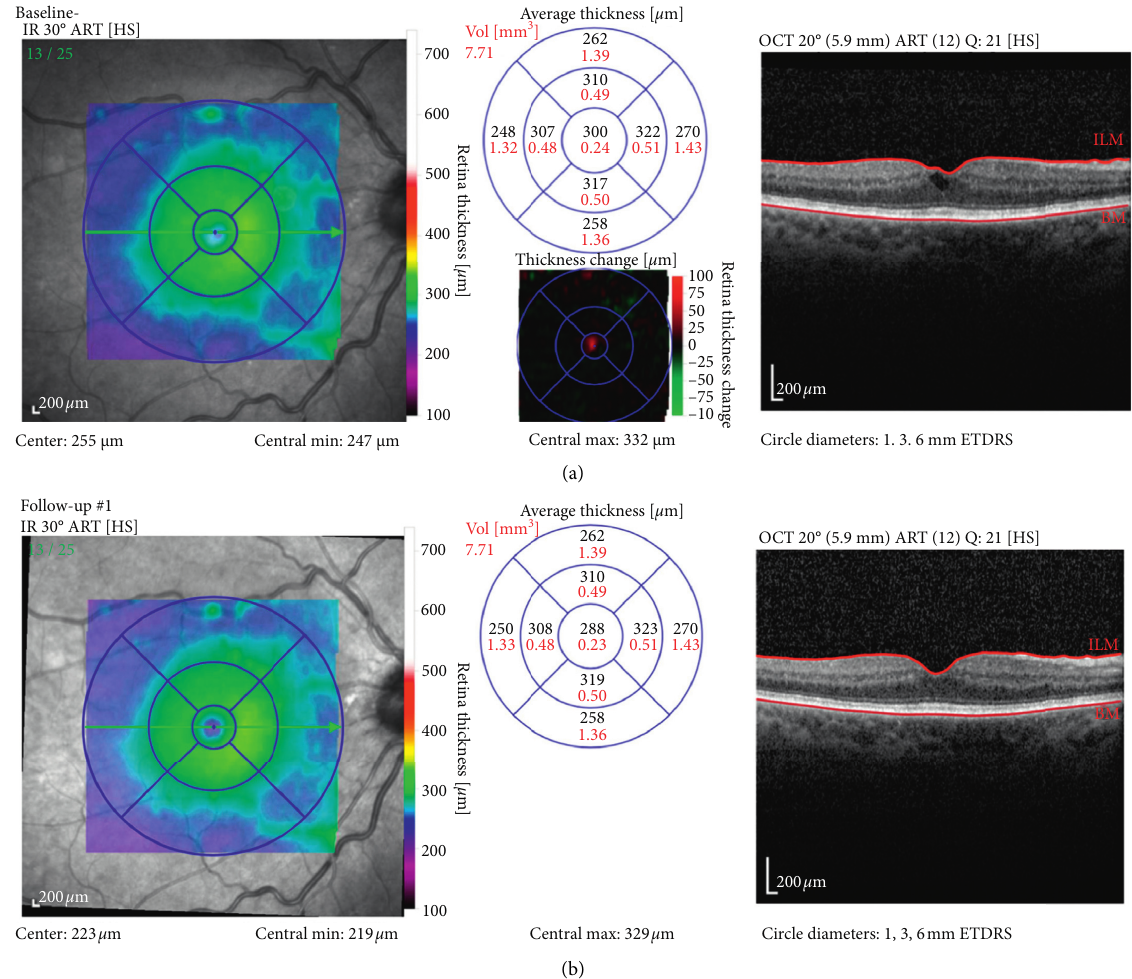
Figure 4: OCT of the macula from the right eye of a patient at baseline and at the 1st visit following 3 months of mask wear. The topographical map is reasonably flat at baseline and remains so throughout (shown only at 2nd visit). The central cross-sectional image (top right) shows a circular pocket of hypofluorescence in the foveal region. This cyst is resolved at the 2nd (3 months) visit (bottom right) and remains so up to and including the exit